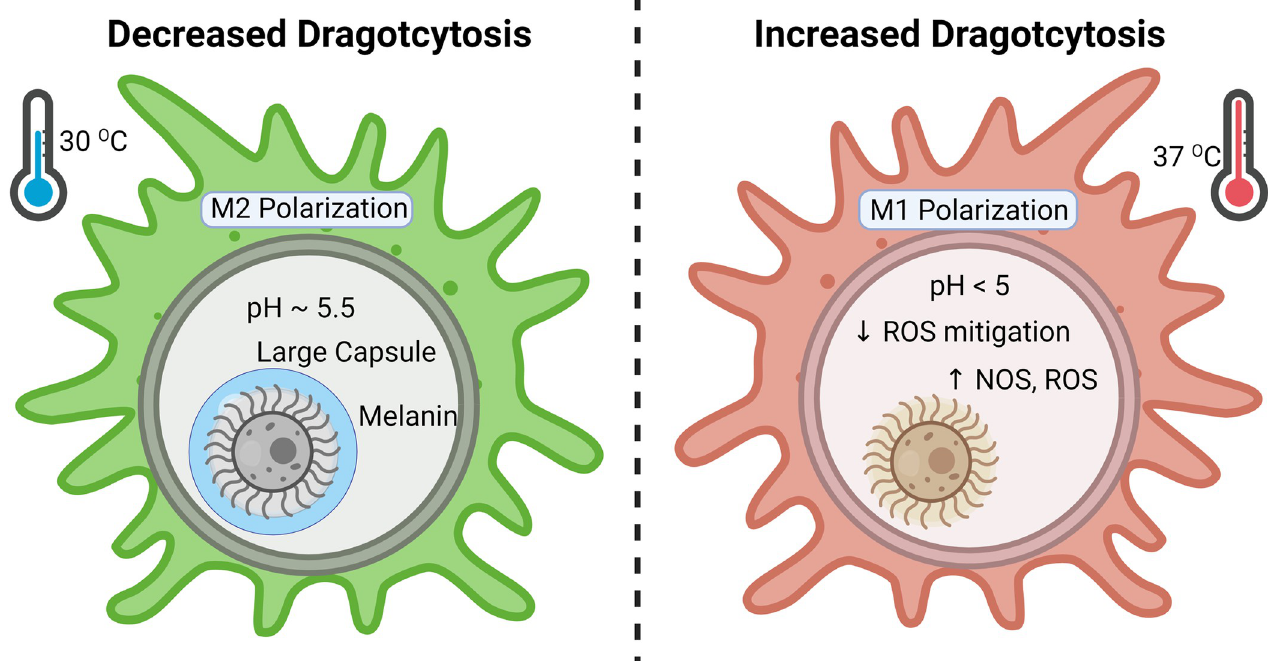
Fig 5. Graphical summary of conditions with effects on Dragotcytosis frequency. Figure was created with BioRender.com.